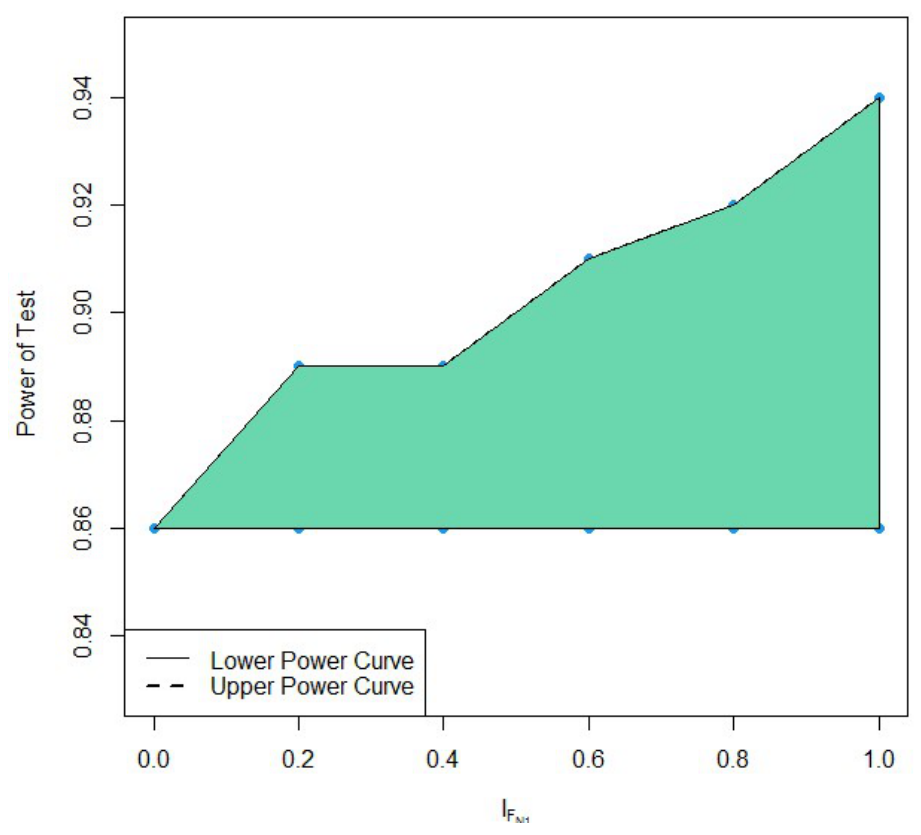
Figure 2. The curve of the power of the test when 𝛼 = 0.01.